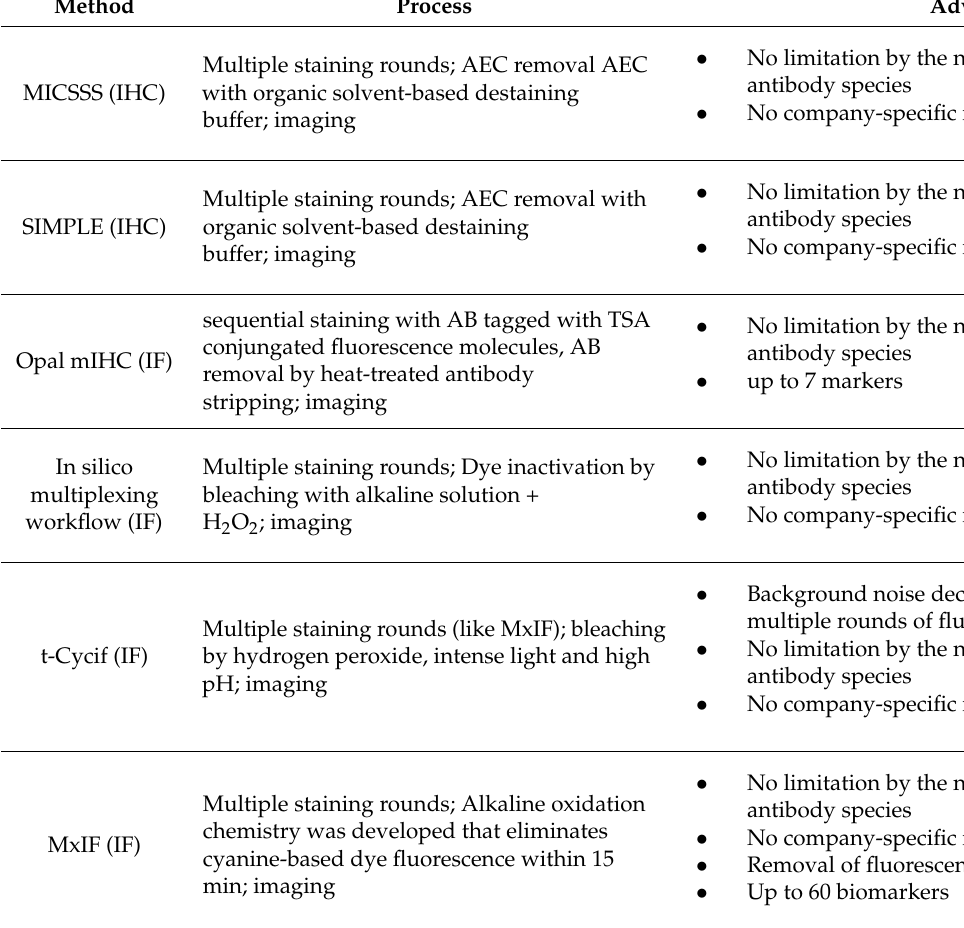
Table 1. IHC and IF multiplexing